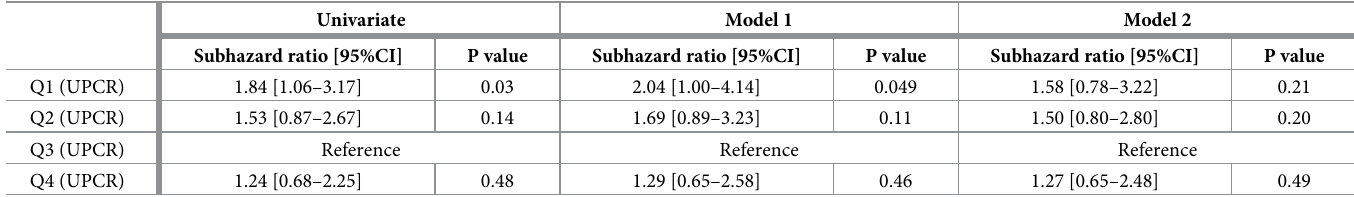
Table 2. Association of quartile with atherosclerotic CVD.